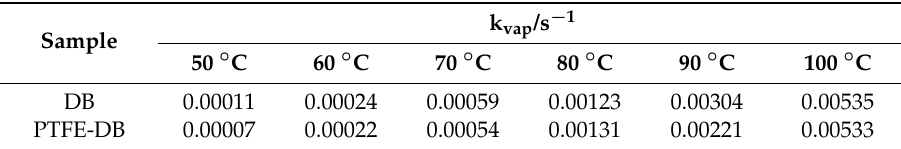
Table 2. The values of evaporation rate constant (k vap